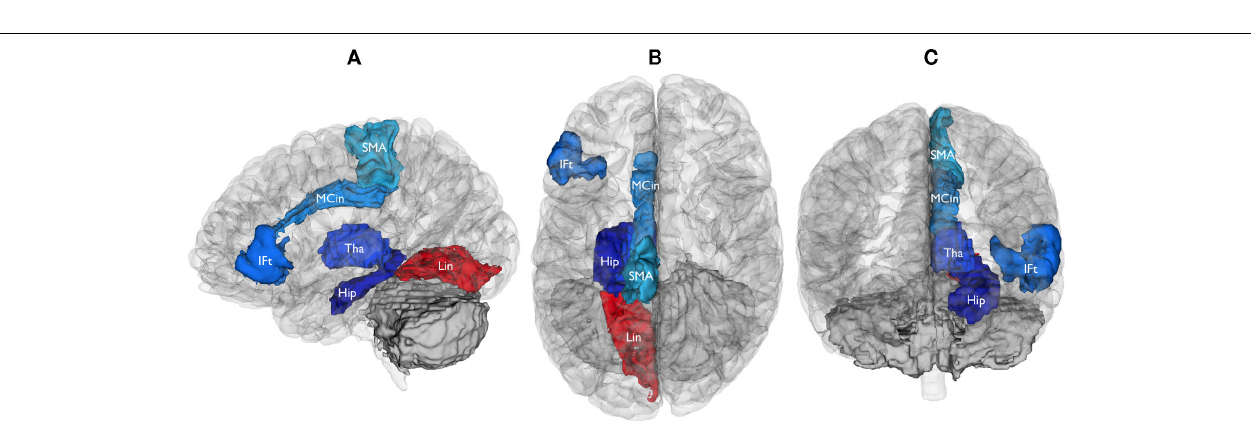
FIGURE 5 | Brain regions functionally dysconnected from the cerebellum in schizophrenia. Left lateral (A) , superior (B) , and anterior (C) views of the brain, showing the cerebral regions that were found to be functionally dysconnected (whole-brain significant) from the cerebellum. Blue signifies decreased functional connectivity with the cerebellum in schizophrenia patients compared to healthy comparison subjects (all p < 0.0025, FDR-corrected), red indicates increased